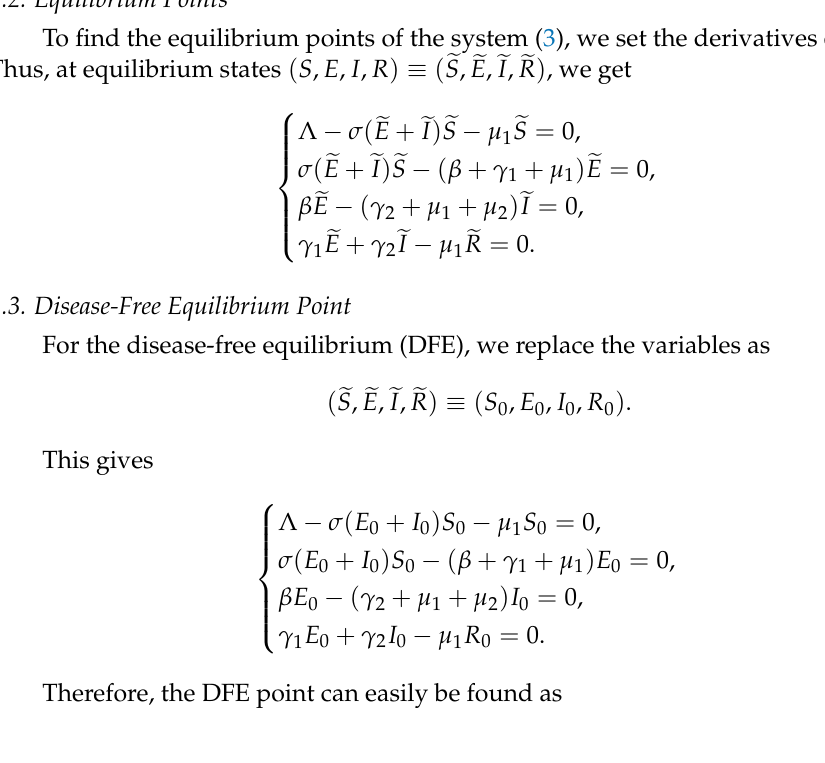
Figure 1. Flow diagram of the modified SEIR model Figure 1: Flow diagram of modified SEIR model.